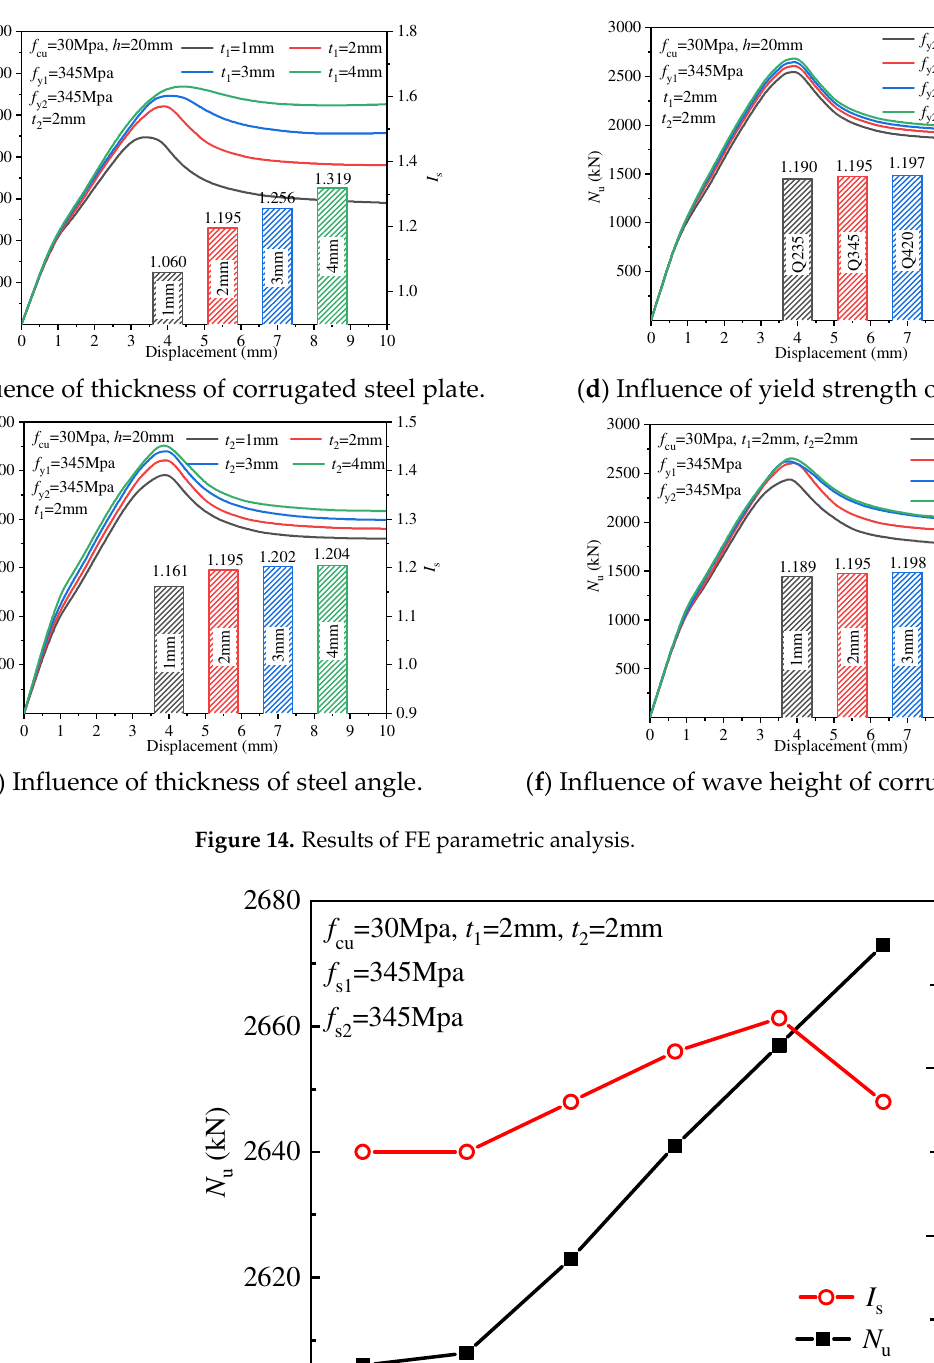
Table 3. Specific parameters and results of models.